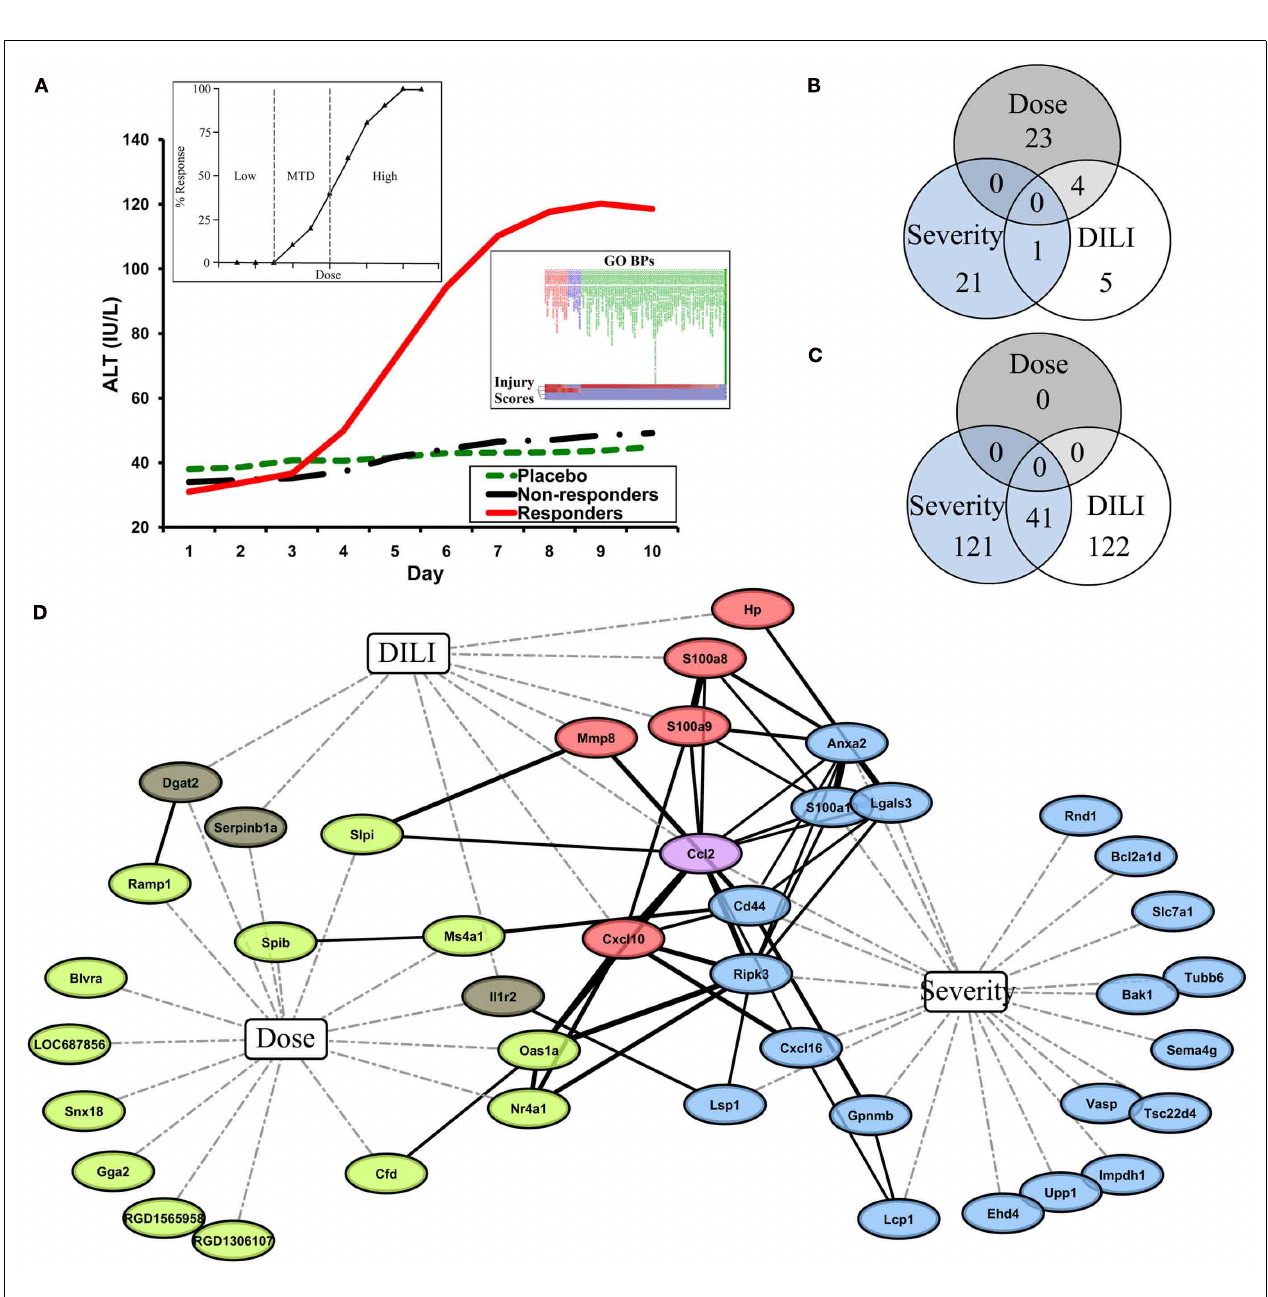
shows a common central gene relational network. Corresponding gene symbols of predictive gene signatures were submitted to STRING to generate a Gene Relational Network (solid black lines; line width correlates to STRING combined score, which is the computed final confidence score for association between two proteins). Nodes are connected to COIs Dose, Severity, and DILI by dashed lines. Node color further represents COI. Green: dose. Brown: dose and DILI. Red: DILI.Violet: DILI and severity. Blue: